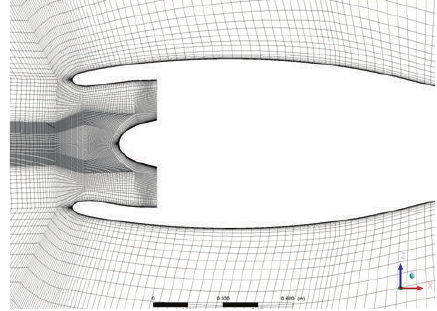
Figure 14: Nacelle